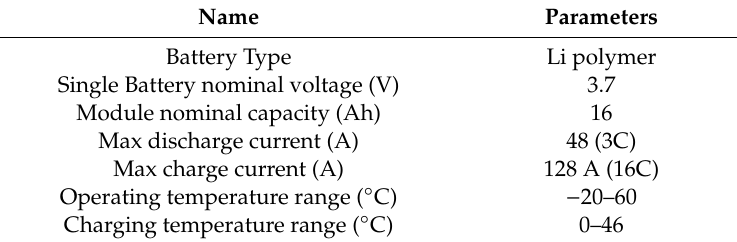
Figure 1. Proposed single Li polymer pouch battery thermal management system (BTMS). Table 1. Specification of the single lithium polymer pouch